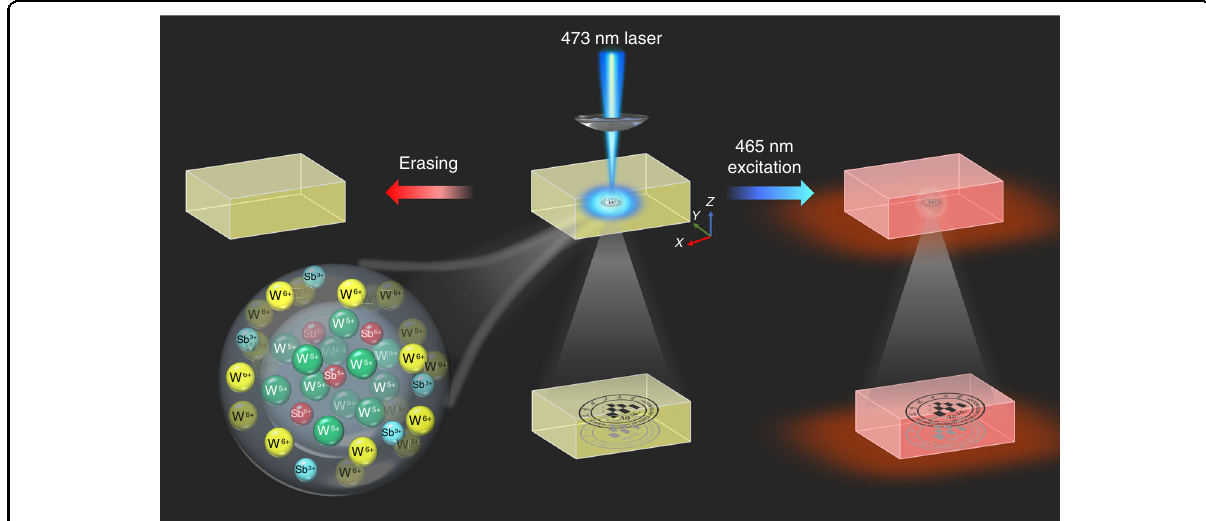
Fig. 1 Schematic of the writing, reading, and erasing of optical information. A focused 473 nm laser beam is irradiated into the glass, and the blue area is the photochromic region of the glass. The 3D optical data are written in transparent glass by a computer-controlled 3D XYZ translation stage. A 465 nm light from xenon lamp is used to excite the glass, and the photochromism-induced luminescence modi fi cation is recorded by a CCD camera. The transmittance or luminescence modulation is recovered by the thermal